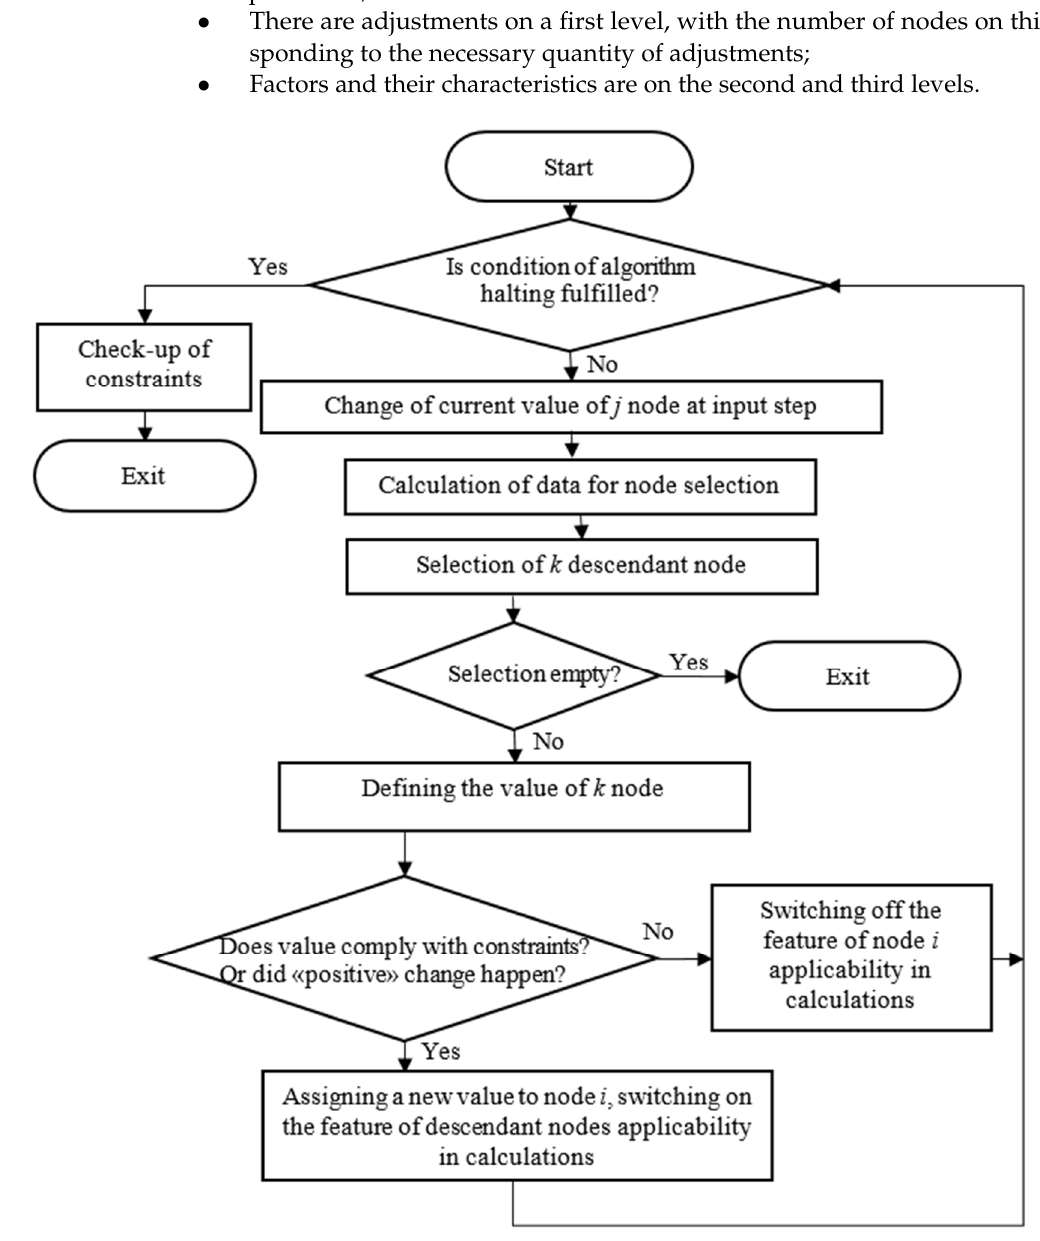
Figure 5. Algorithm for solving the inverse problem when selecting the node for change.